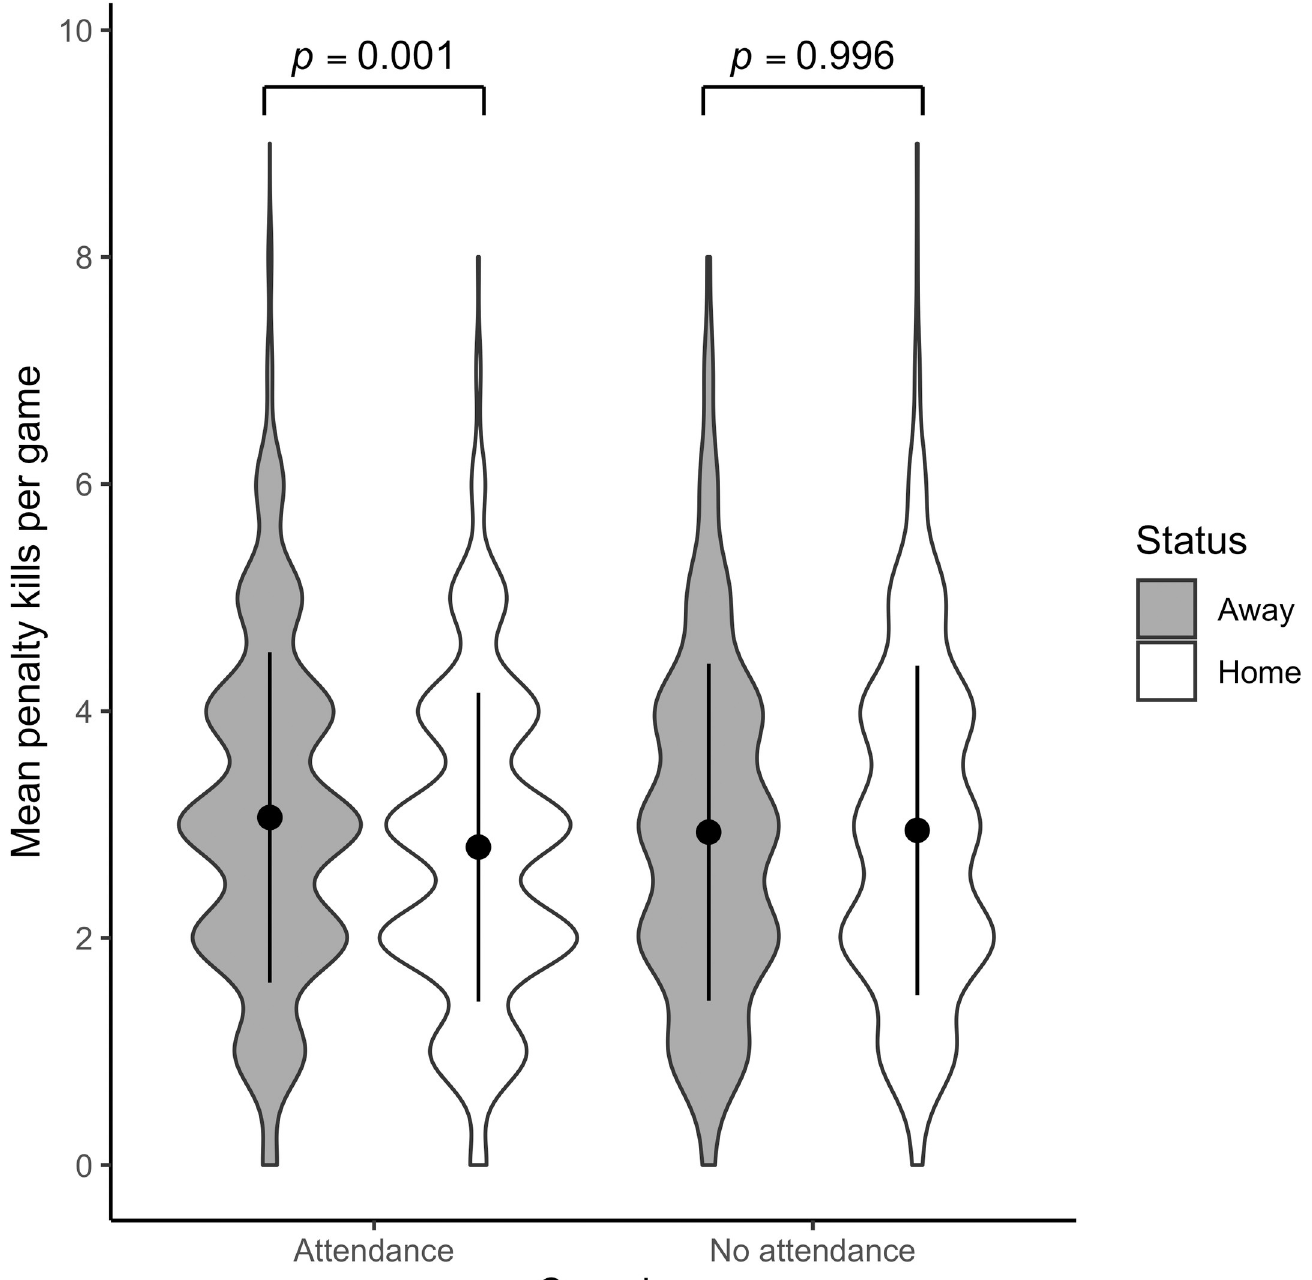
Fig 2. Mean penalty kills per team with and without attendance during the NHL regular season. For the sake of simplicity, the raw data have been presented in the figure, even though the model results in Tables 5 and 6 are in log-odds.